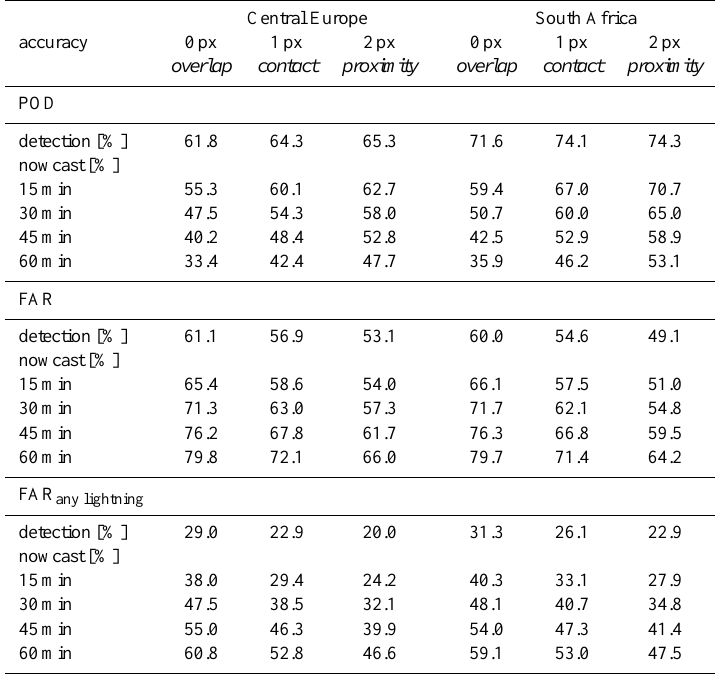
Table A4. Full day: object-based validation scores for the current Cb-TRAM detection scheme (day and night) for mature storms, and the 15, 30, 45 and 60min forecasted objects. Top – POD for intense lightning objects ( > 10flashespixel − 1 15min − 1 ); centre – FAR with regard to intense lightning objects ; bottom – FAR any lightning with regard to objects containing any lightning ( > 0flashespixel − 1 15min − 1 ). Central